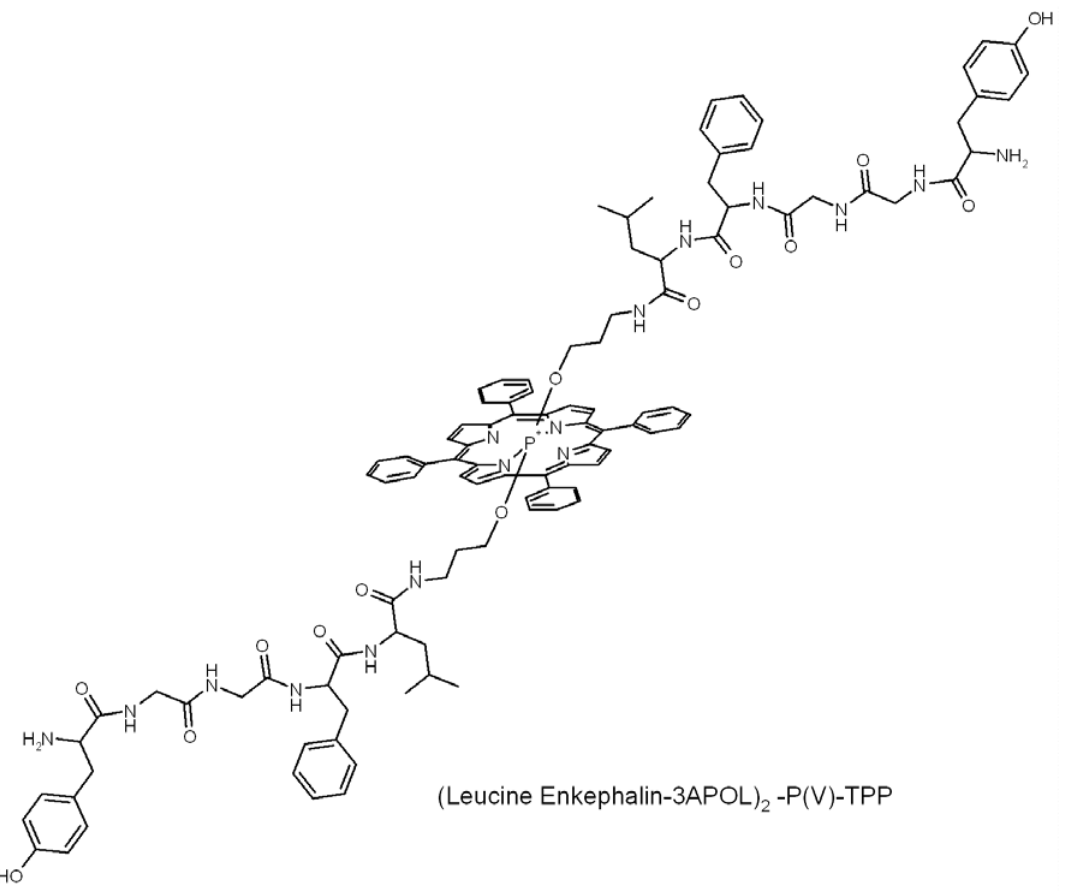
Fig. 3 Structure of the target compound: P(V) porphyrin diaxially substituted with